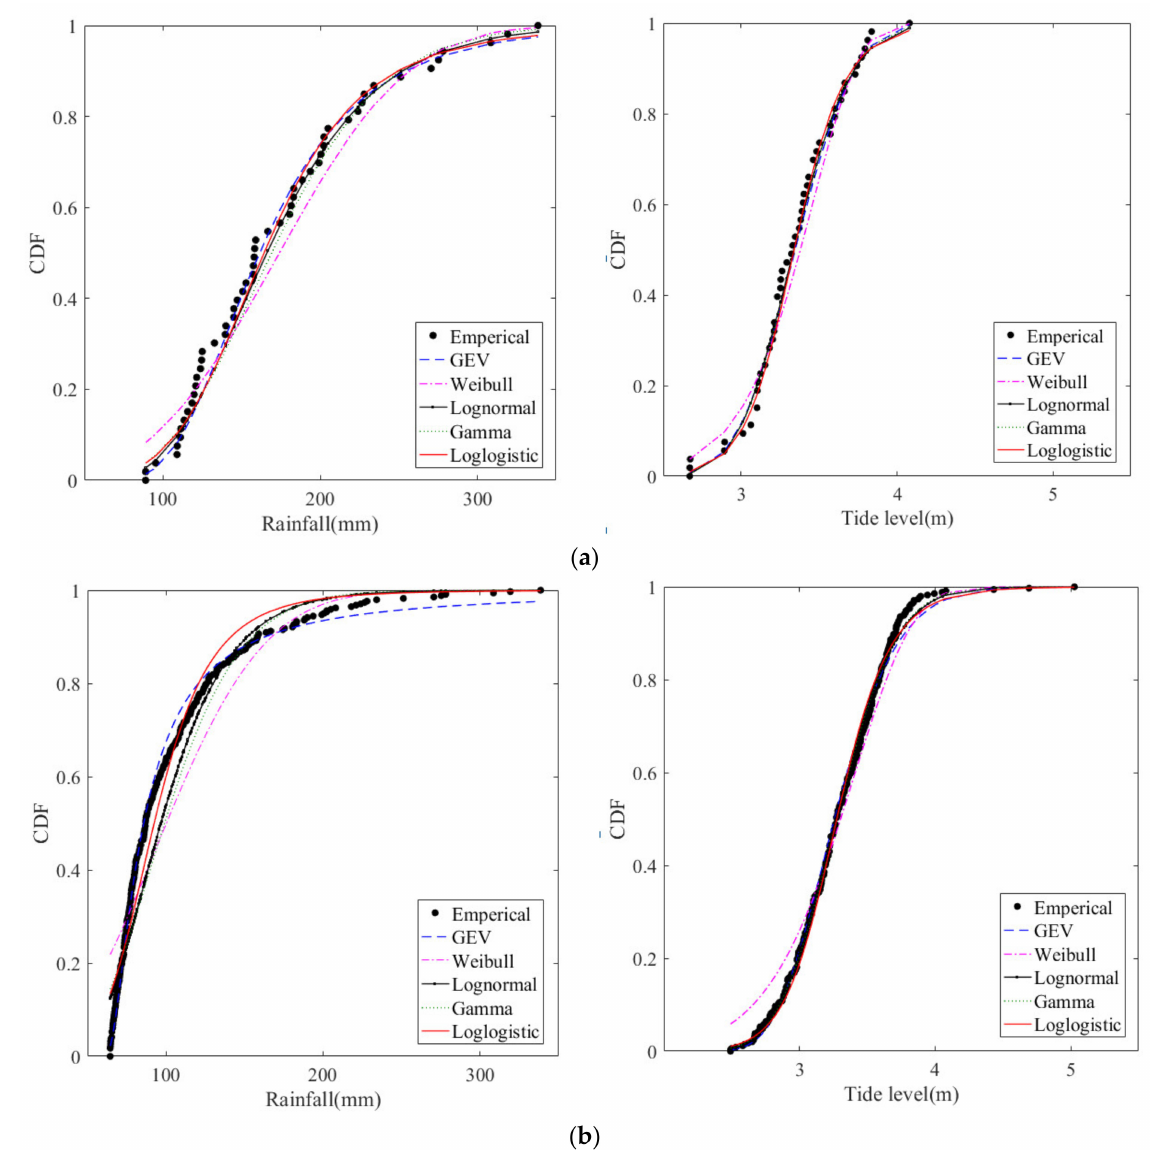
Figure 4. Comparison of cumulative distribution functions (CDF) of extreme rainfall and tide level series obtained using two sampling methods. ( a ) Annual maxima. ( b ) Peaks over threshold. Although the marginal distributions of extreme rainfall and high tide level series obtained using the two sampling methods are identical, their parameters are different (Table 3). For the extreme rainfall series, the scale parameter of the annual maxima method is larger than that of the peaks over threshold method, whereas the converse is true for the corresponding high tide level series. It indicates that the marginal distribution of the extreme rainfall series sampled using the peaks over threshold method is more concentrated, whereas the marginal distribution of the corresponding high tide level series sampled using the annual maxima method is more